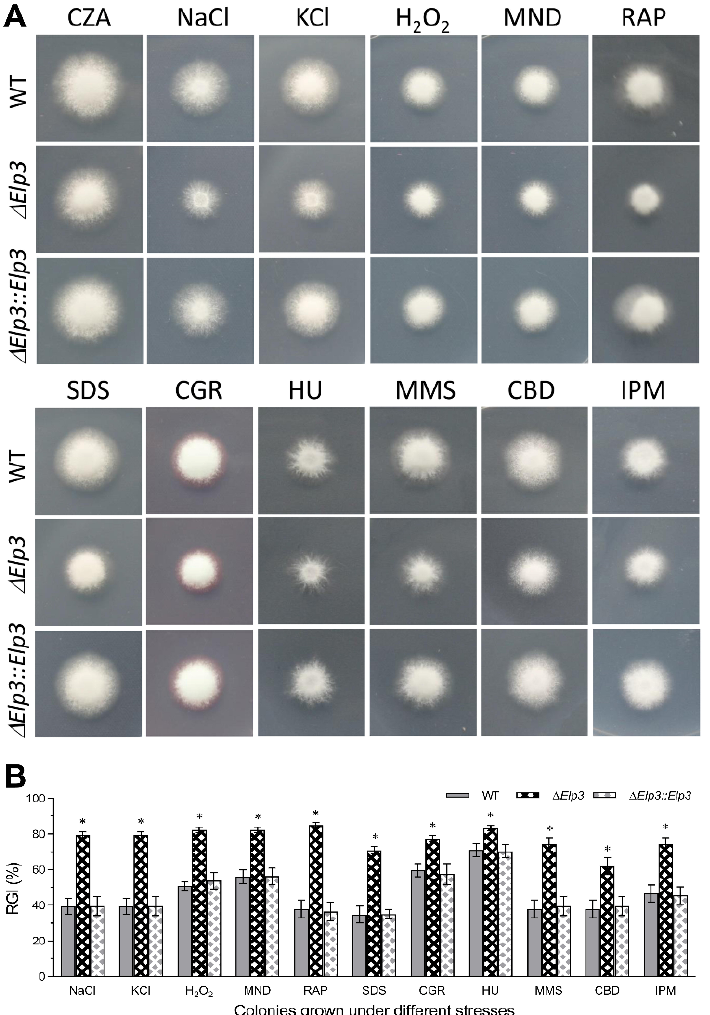
Figure 2. Contribution of BbElp3 to multi-stress tolerances. ( A , B ) Representative images and quan- tification of relative growth inhibition (RGI) of fungal colonies grown at 25 ° C for 8 d on CZA sup- plemented with NaCl (0.4 M), KCl (0.4 M), H 2 O 2 (2 mM), menadione (MND; 0.02 mM), rapamycin (RAP, 1 μ g mL − 1 ), SDS (100 μ g mL − 1 ), Congo Red (CGR; 10 μ g mL − 1 ), hydroxyurea (HU; 10 mM), methyl methanesulfonate (MMS, 0.05%), carbendazim (CBD, 10 μ g mL − 1 ), and iprodione metabolite (IPM, 10 μ g mL − 1 ). All colonies were initiated by spotting 1 μ L of 1 × 10 6 conidia/mL suspension on the plates. All experiments were performed three times, with each containing three technical repli- cate plates. Error bars = ± SD. Asterisk indicate significant difference ( p < 0.05) from unmarked (Tukey’s HSD). Error bars: SD from three technical replicates.